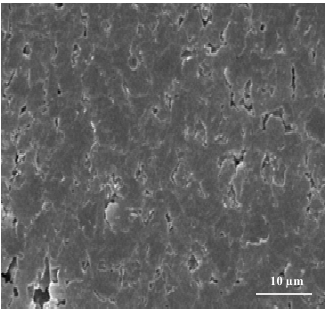
Figure 2. Scanning electron microscopy (SEM) image of extracted Gr.